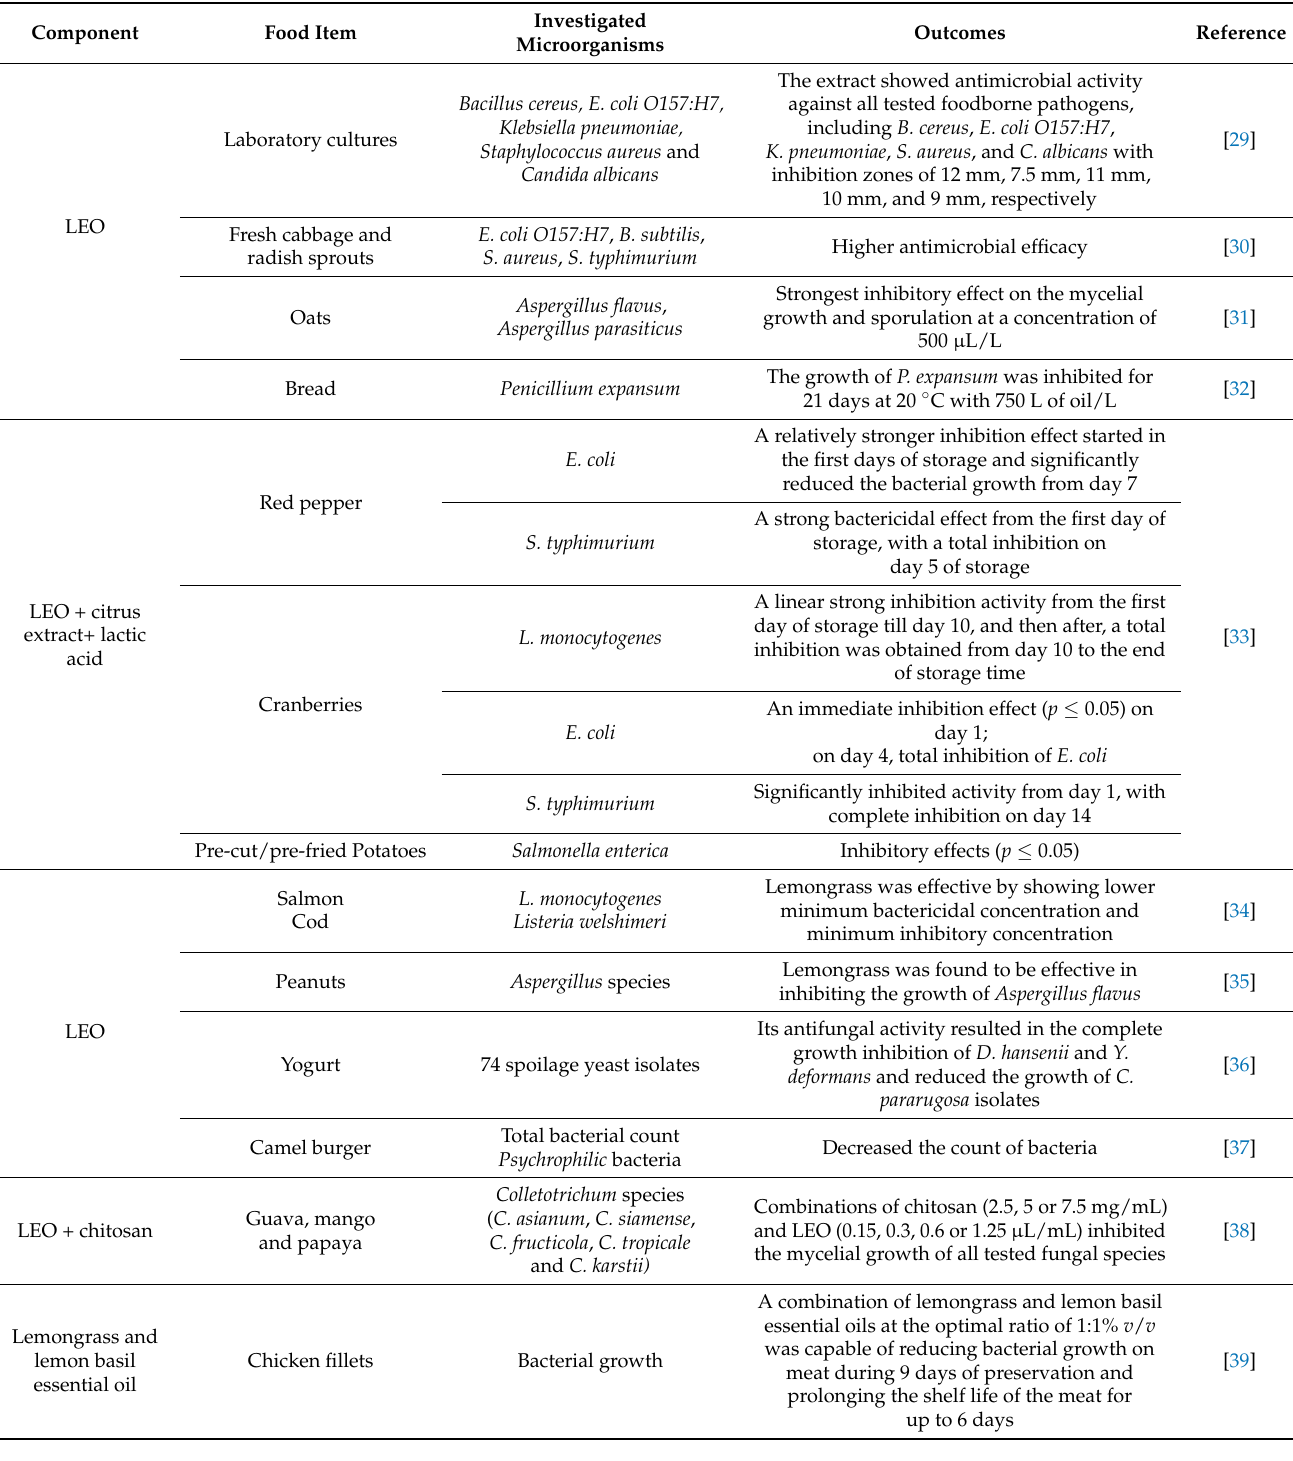
Table 1. Antimicrobial and antifungal activity of lemongrass in a